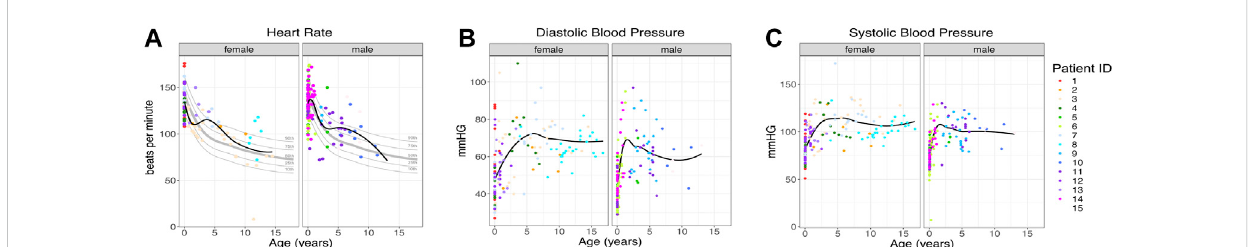
Patientvitalsigns. (A) Heartrateperpatient.Theblacklineindicatesthetrendline.Graylinesindicatethe10th,25th,50th,75th,and90thpercentiles byage(Flemingetal.,2011), n =259. (B,C) Diastolicandsystolicbloodpressureforeachpatient, n =700.Theblacklineindicatesthetrendline.Individual patients are indicated by individual colors.